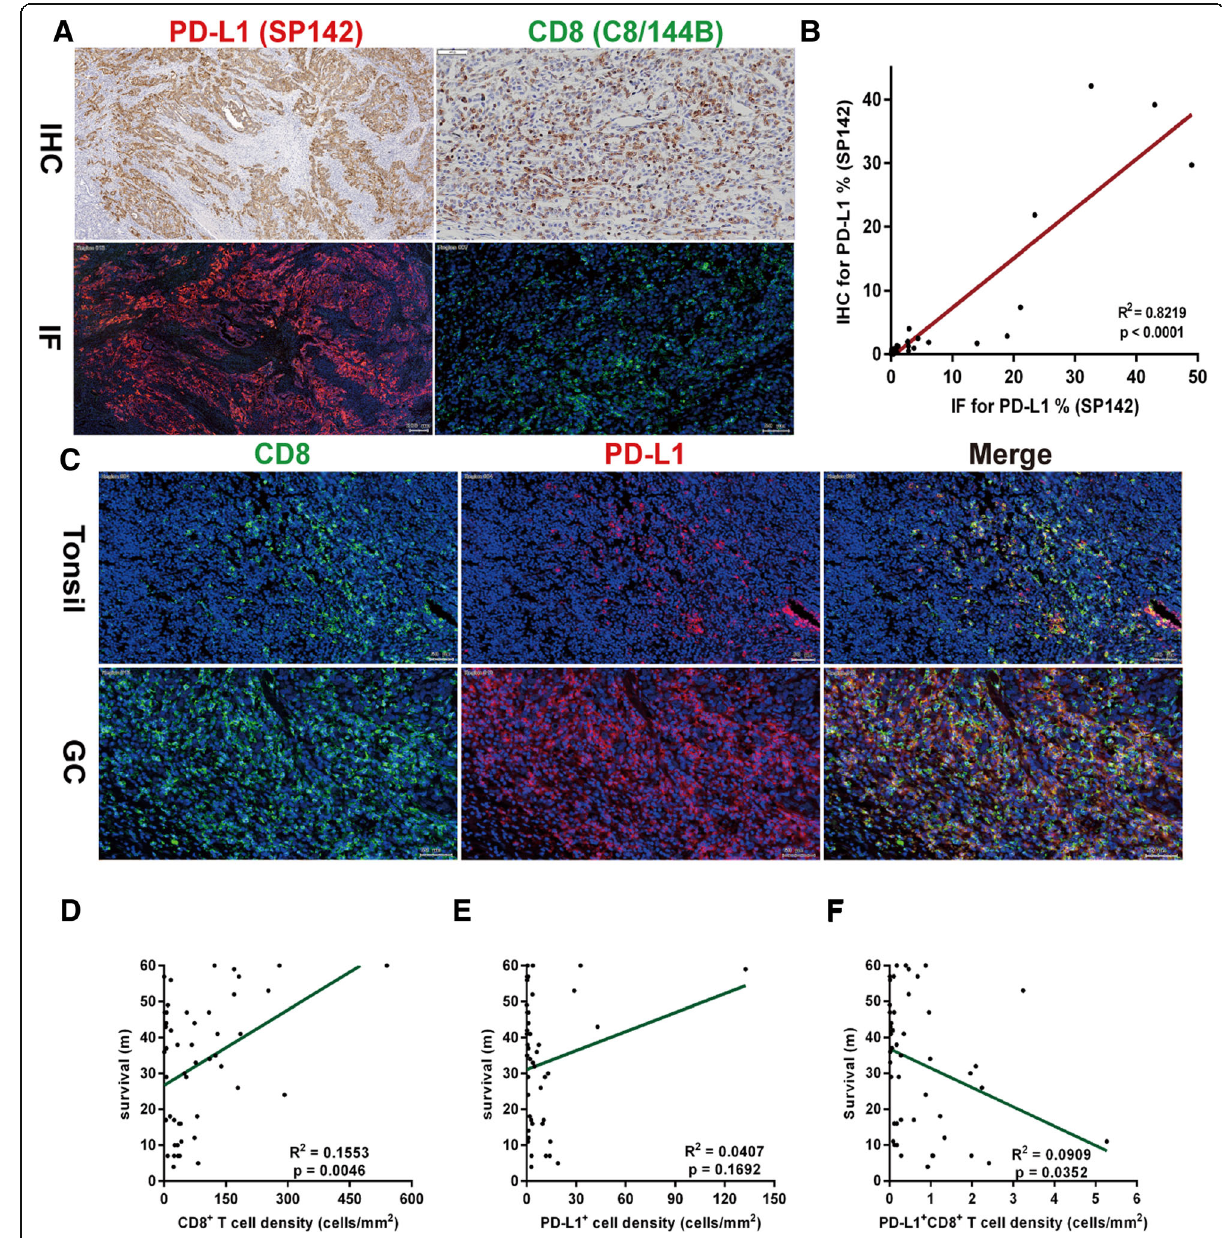
Fig. 5 Quantitative analysis of the correlation between density of PD-L1 + CD8 + T cells and survival. a Immunofluorescence (IF) for PD-L1 clone SP142 and CD8 clone C8/144B showed an extremely similar staining pattern as IHC, with a strong correlation (R 2 = 0.8219) for PD-L1 ( b ). Each dot represents a single specimen. Normal tonsil tissue was used as a positive control. c Representative images of IF staining in tonsil tissue and GC are shown, in which CD8 was recognized in the Cy5 channel (green) and PD-L1 was recognized in the Texas Red channel (red) and displayed membrane expression. d A positive correlation was shown between the density of CD8 + T cells and survival time. e No relationship was observed between the density of PD-L1 + cells and survival. f A negative correlation was shown between the density of PD-L1 + CD8 + T cells and survival time. PD-L1, programmed death ligand 1; IF, immunofluorescence; GC, gastric